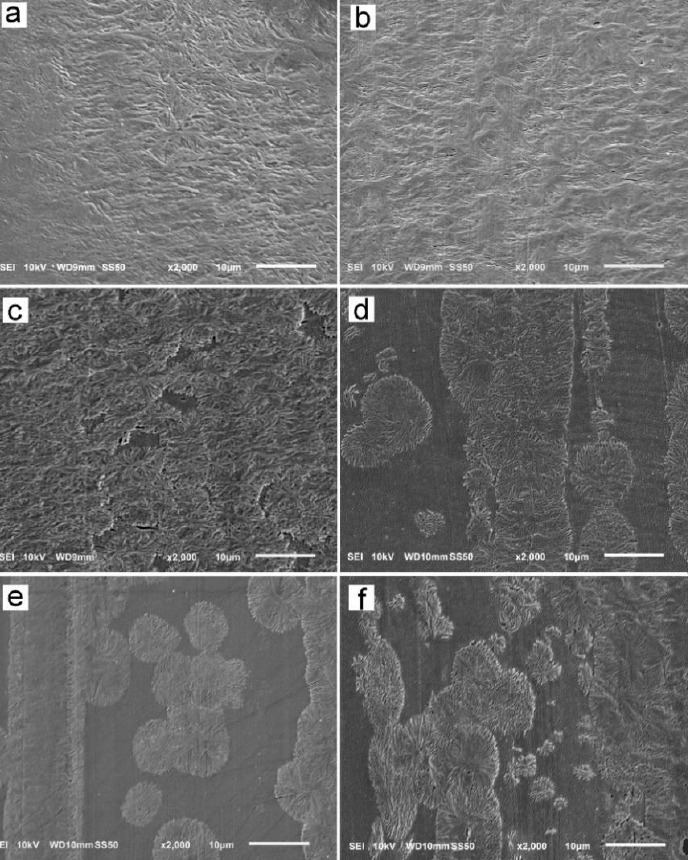
Figure 10. SEM micrographs of etched cross-section surfaces of PLLAs: L339 sheared at 170 °C at 5 /s for 20 s, and next cooled at 10 °C/min ( a ), and L240 ( b ) 6S245 ( c ), L121 ( d ), 4S123 ( e ), 6S120 ( f ) sheared at 150 °C at 20 /s for 5 s, and next cooled at 30 °C/min. Shearing direction – vertical.